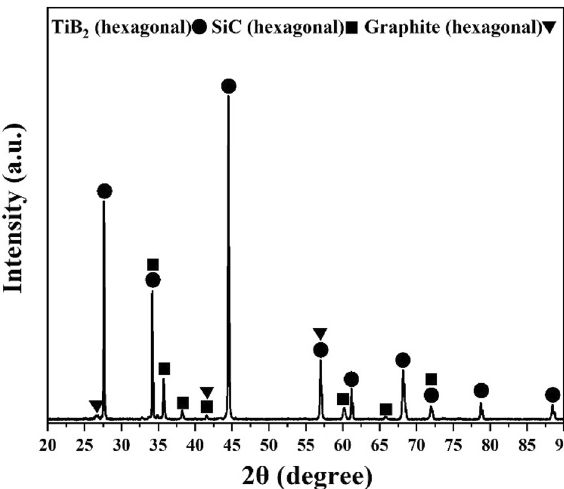
Figure 2. XRD pattern of C f -incorporated TiB 2 –SiC